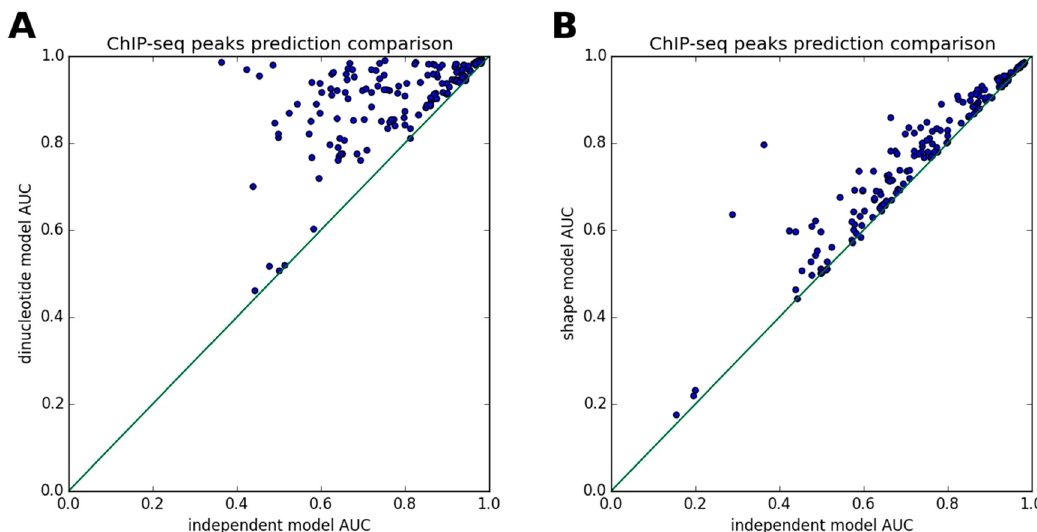
Figure 2. ChIP-seq peaks prediction is improved in dependency of the models. For each of the 172 ChIP-seq datasets for 36 TFs, the area under receiver operating characteristic curve (AUC) of the independent model is compared to ( A ) the full dinucleotide model, which has a separate tunable parameter for each of 16 possible dinucleotides at each position; and ( B ) the DNA shape-restricted dinucleotide model, which has a separate tunable parameter for each shape feature (e.g., four DNA shape features in the current study) at each position.